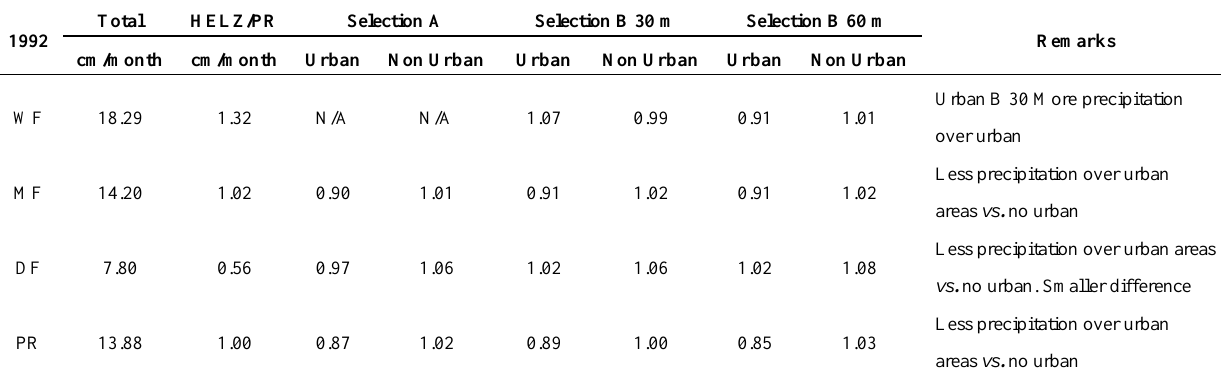
Table 6. 1992 land use and land cover (LULC) average monthly precipitation ratio 1900–2007.